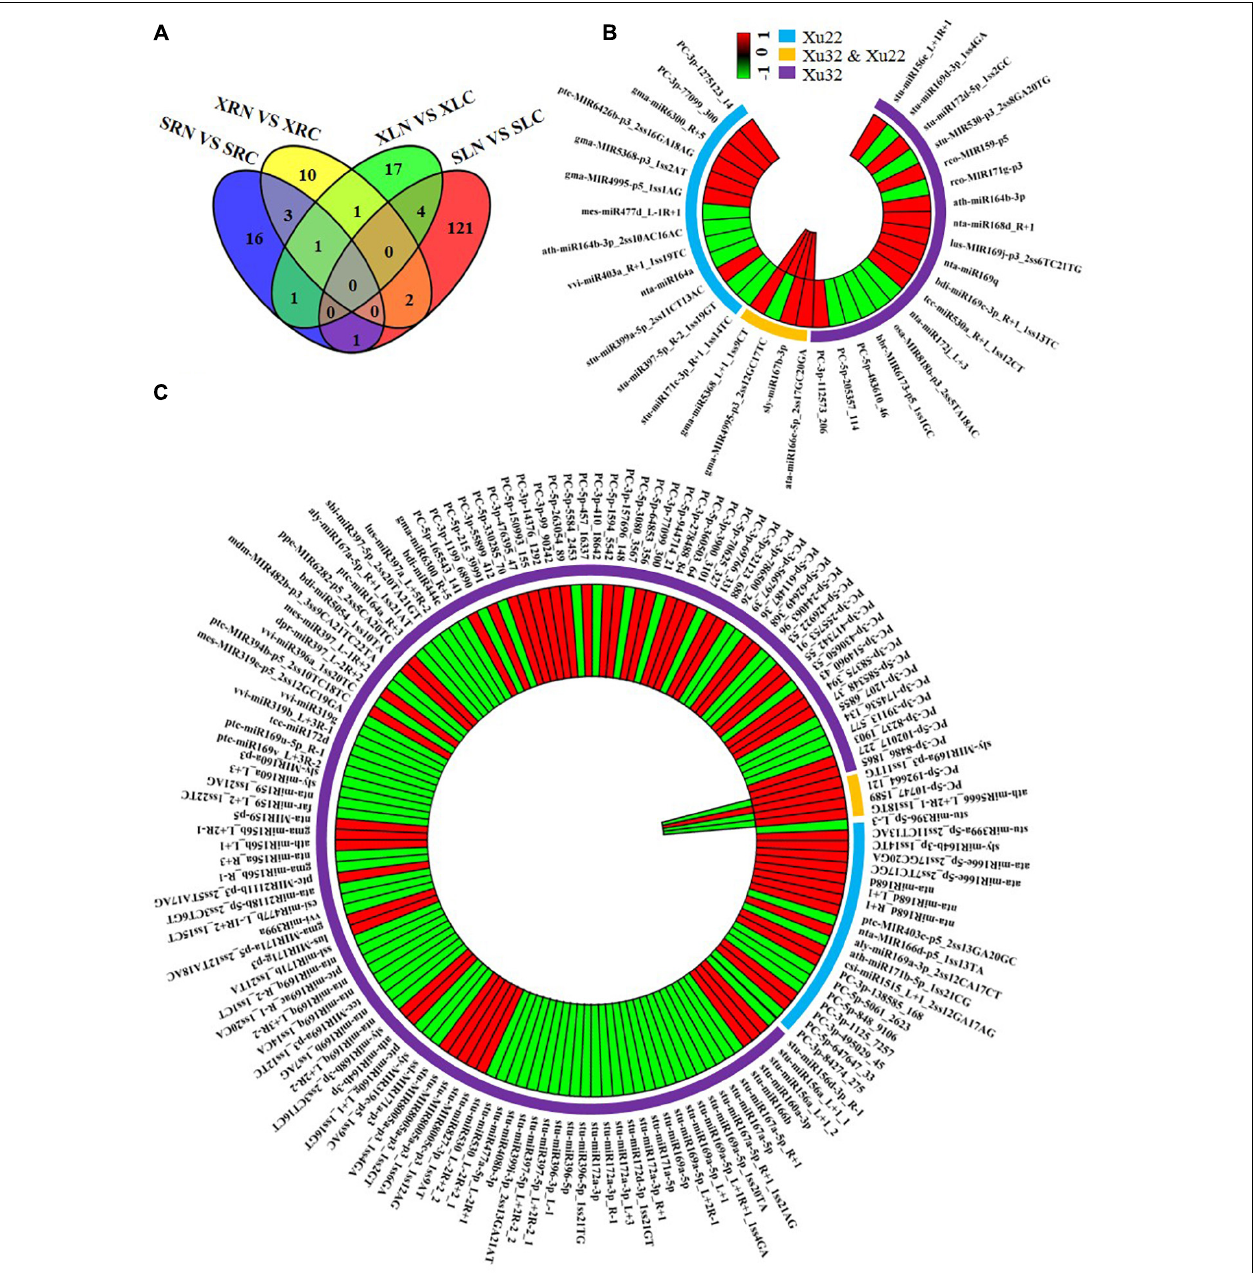
FIGURE 5 | Salt-responsive miRNAs in leaves and roots. (A) Salt-responsive miRNAs in roots and leaves; (B) Salt-responsive miRNAs in roots; (C) Salt-responsive miRNAs in leaves. Each bar in panels (B,C) represents a miRNA. Red bars represent miRNAs (salt/control) with log 2 (fold change) ≥ 1; green bars represent miRNAs (salt/control) with log 2 (fold change) ≤ –1; the blue outer ring represents miRNAs with significant differential expression in “Xushu 22”; the yellow outer ring represents miRNAs with significant differential expression in “Xushu 32” and “Xushu 22”; the purple outer ring only represents miRNA with significant differential expression in “Xushu 32.” The first and second layer from the center of panels (B,C) indicates “Xushu 22” and “Xushu 32,” respectively. Significant difference between salt-stressed sweetpotato and control sweetpotato is indicated by p -value ≤